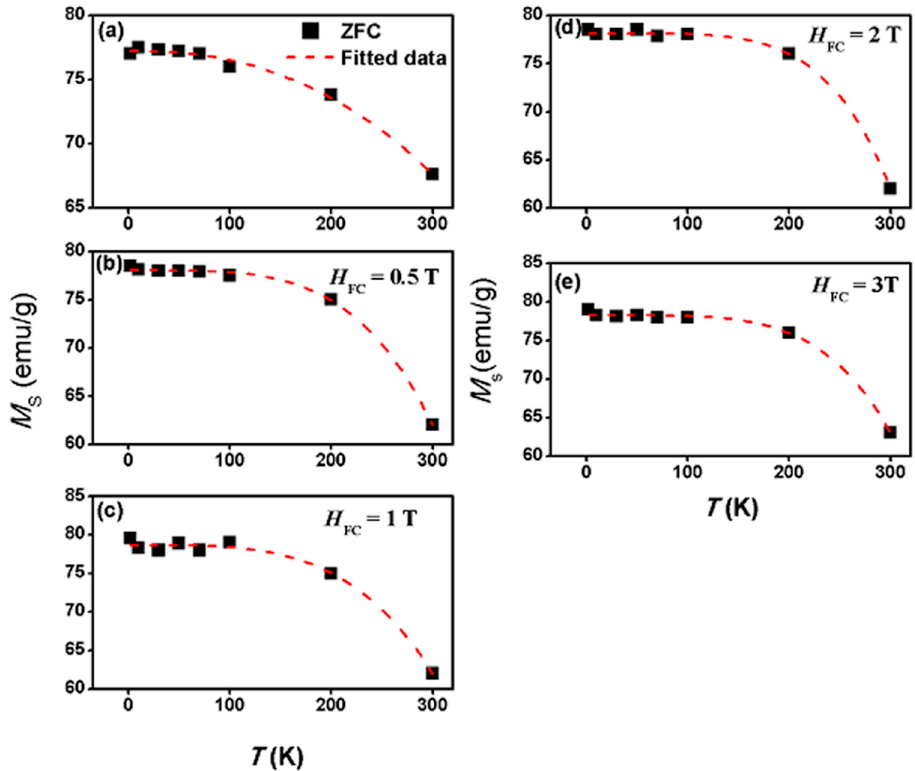
Figure 7. Temperature dependence of the saturation magnetization (in sample S1) measured under ( a ) the zero field-cooling (ZFC) condition and under the field-cooling (FC) condition at several field-cooling values of ( b ) 0.5 T, ( c ) 1 T, ( d ) 2 T, and ( e ) 3 T. The dashed lines represent the fittings of the experimental data to modified Bloch’s laws.